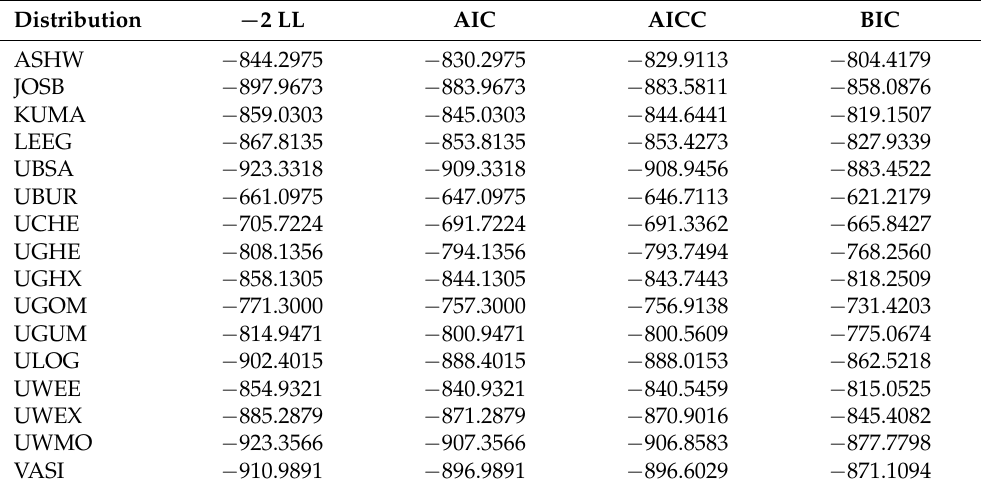
Table 17. Values of the indicated likelihood-based statistic and distribution for τ = 0.50 with data related to fat percentage at the arms.